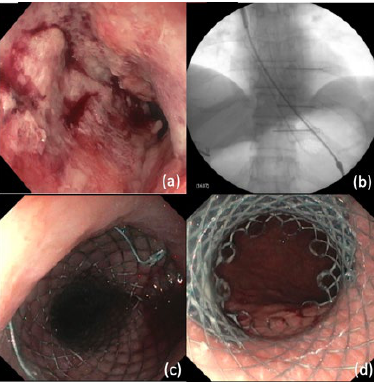
Figure 5. Esophageal stent placement. ( a ) Moderate luminal narrowing from squamous cell carcinoma ( b ) Placement of partially-covered metal stent over a wire under fluoroscopic guidance ( c ) Proximal end of partially-covered metal stent ( d ) Distal end of partially-covered metal